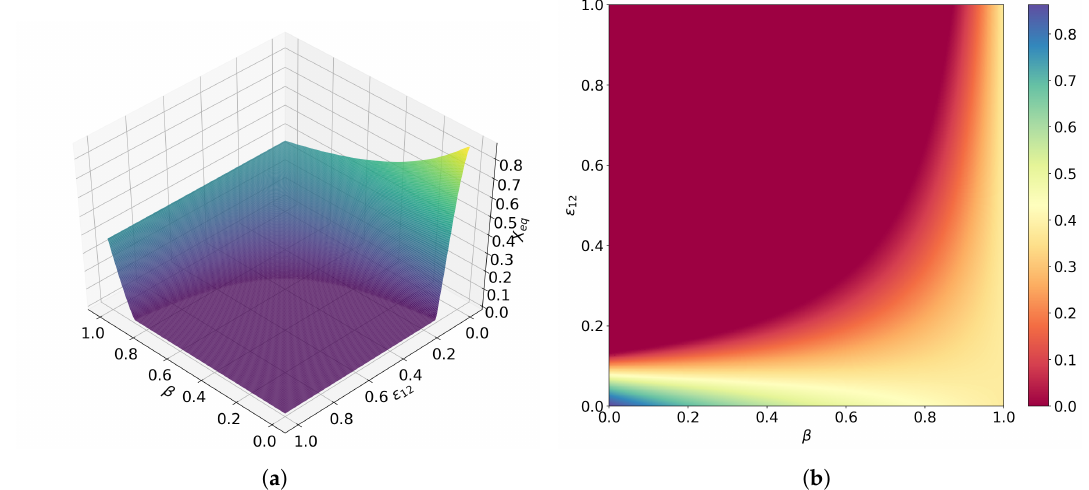
as a function of ε 12 and β plotted as a surface ( a ) and a heat 1